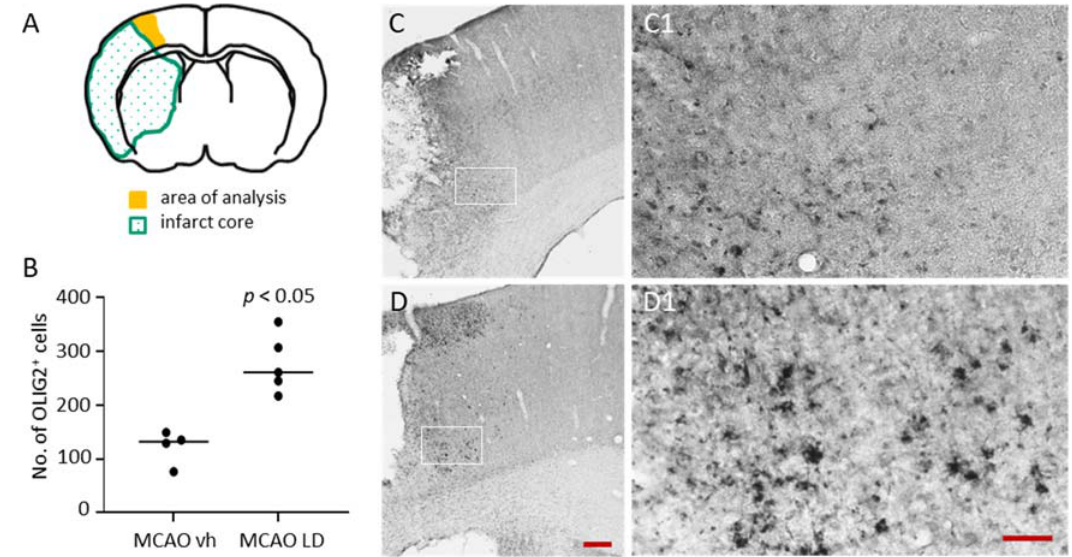
Figure 5. Impact of levodopa treatment on OLIG-2 positive cells following tMCAO. ( A ) Quantification of Oligodendrocyte transcription factor (OLIG-2) positive cells in the proximal peri-infarct area ( B ) with quantification of cells in vehicle (saline; n = 4) and levodopa-treated rats (LD 20 mg/kg; n = 5) 14 days after tMCAO. Statistical analysis was performed by the Mann–Whitney test. ( C ) Illustration of OLIG-2 positive cells in the peri-infarct area of a rat treated with vehicle (saline) and ( D ) in a rat treated with levodopa (20 mg/kg) 14 days after the insults. Higher magnification of the inserts in ( C ) and ( D ) are shown in ( C1 ) and ( D1 ), respectively. Scale bars: C and D—200 µm, C1 and D1—50 µm. Regulation of Nogo A receptor (NgR) and Growth-Associated Protein 43 (GAP43) following treatment with levodopa.